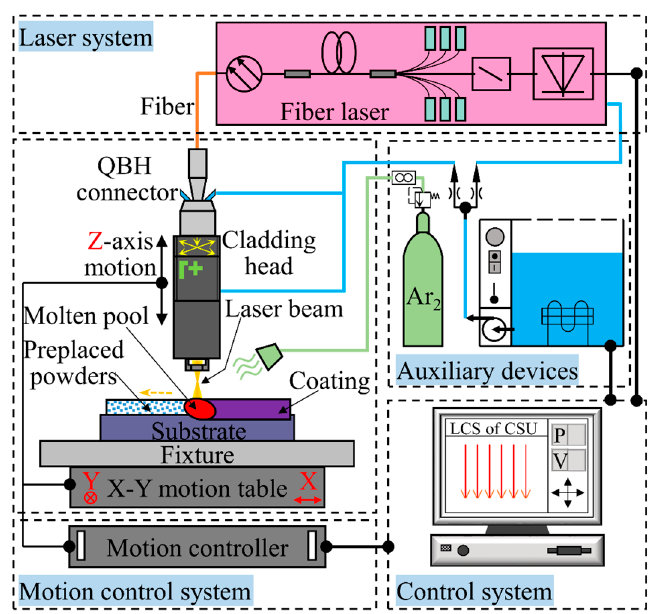
Figure 1. Schematic illustration of the laser-cladding system.